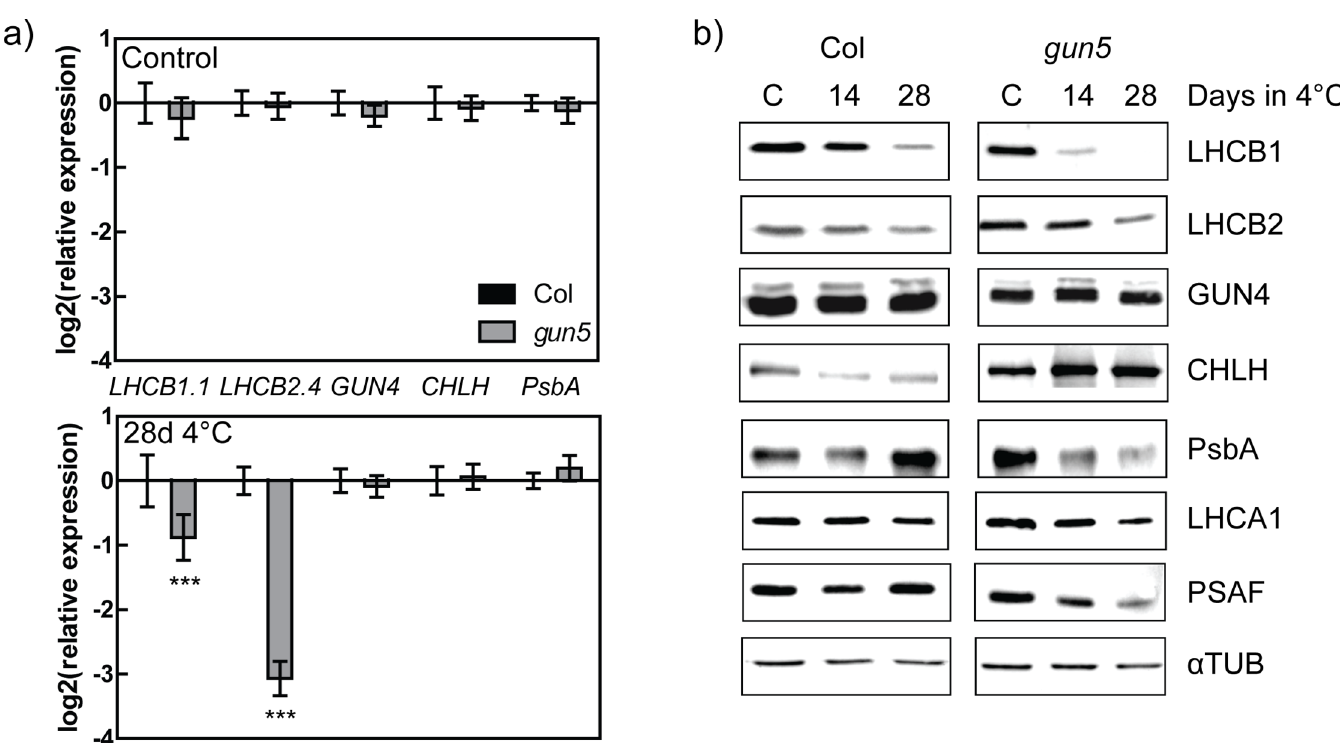
Fig 3. Gene expression and protein levels in Col-0 and the gun5 mutant following exposure to low temperatures. (a) Expression of photosynthetic associated genes in gun5 relative to Col-0 in 5 week old plants grown in control conditions and after 28 days in low temperature (4°C). The expression was normalized to Ubiquitin like protein (At4g36800) and related to the amount present in Col-0. Each data point represents values from 3 biological replicates ( ± SD). Significant differences were found with Two-way ANOVA and Bonferroni post-test, p < 0.001 ( *** ). (b) Protein levels of photosynthetic proteins in Col- 0 and gun5 in control condition and following 14 and 28 days exposure to low temperature. α TUB was used as a loading control.